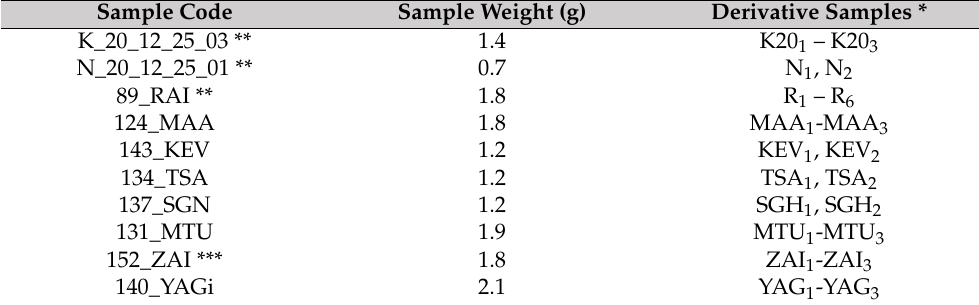
Table 2. List of samples.